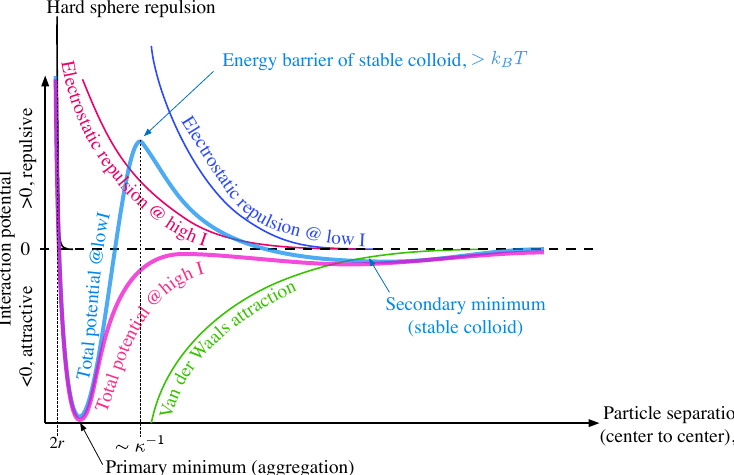
Figure 2. Qualitative sketch of the interaction potential between electrostatically stabilized colloidal particles, as a function of particle separation x , at low (blue) and high (pink) ionic strength I , respectively, according to DLVO theory. Each main contribution (thin curves) to the total energy is sketched in addition to the total interaction potential (thick curves). At low I , an electrostatic energy barrier at a distance ∼ κ − 1 (the Debye screening length) from the particle surface, prevents the particles from reaching the primary minimum that corresponds to particle aggregation and loss of colloid stability. The reduction of the electrostatic repulsion range upon increasing I eventually reduces the energy barrier to such an extent that thermal fluctuations will bring the particles to the primary minimum, at a separation distance shorter than κ − 1 , and the colloid loses its